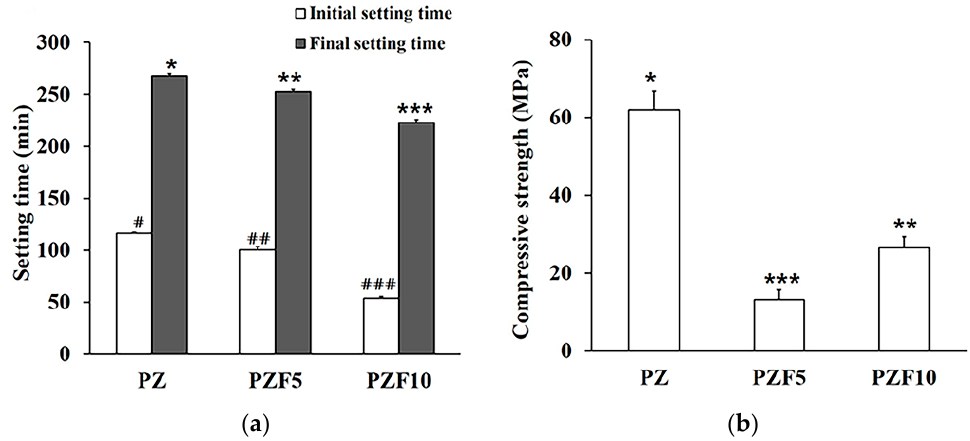
Figure 1. ( a ) Initial/final setting time and ( b ) compressive strength of the experimental groups: PZ (80 wt% of Portland cement and 20 wt% of zirconium oxide as base components), PZF5 (PZ plus 5 wt% of fucoidan), and PZF10 (PZ plus 10 wt% of fucoidan). *, **, *** indicates a significant difference between the groups with different fucoidan content (final setting time and compressive strength). #, ##, ### indicates a significant difference compared to the groups with different fucoidan content (initial setting time).